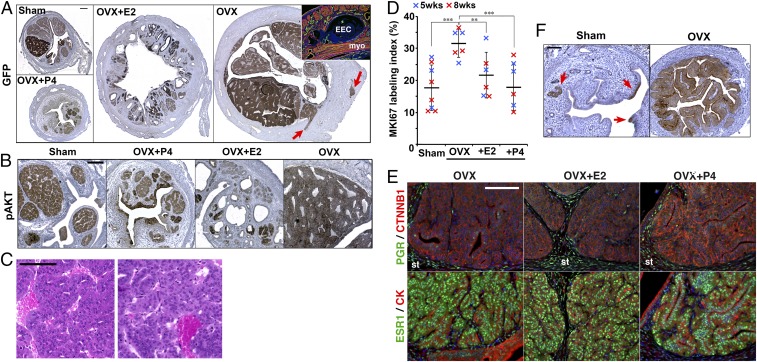
Steroid hormone deficiency promotes endometrial carcinogenesis. (A and B) The uterine pathology of triple-gene mutant mice was compared among sham-operated (Sham), ovariectomized (OVX), OVX+P4, and OVX+E2 groups at 8 wk after mutagenesis. (A) Uterine size and gross morphology of epithelial lesions (highlighted by GFP immunohistochemistry). Myoinvasive lesions are indicated by arrows. IF staining (red for ACTA2 and green for collagen IV) of a myoinvasive lesion in OVX group is shown in Inset. (B) Morphology of epithelial lesions (highlighted by pAKT immunohistochemistry). (C) Representative histopathology (H&E staining) of EECs in OVX group at 6 wk after ovariectomy. (D) Effect of E2 and P4 on epithelial MKI67 labeling index in glandular hyperplasia. Blue and red plots represent values at 5 and 8 wk after mutagenesis, respectively. The horizontal lines and vertical lines indicate average and SD, respectively. **P < 0.01, ***P < 0.001. (E) Effect of E2 and P4 on the expression of PGR and ESR1 in glandular hyperplasia of triple-gene mutant mice. St, stroma. (F) Effect of castration on PTEN+PI3K double-gene mutant lesions. pAKT immunohistochemistry at 6 wk after virus injection (4 wk after sham operation or ovariectomy) is shown. Red arrows in Sham group indicate pAKT-positive cells. (Scale bars: A, 200 μm; B–D. 100 μm.)